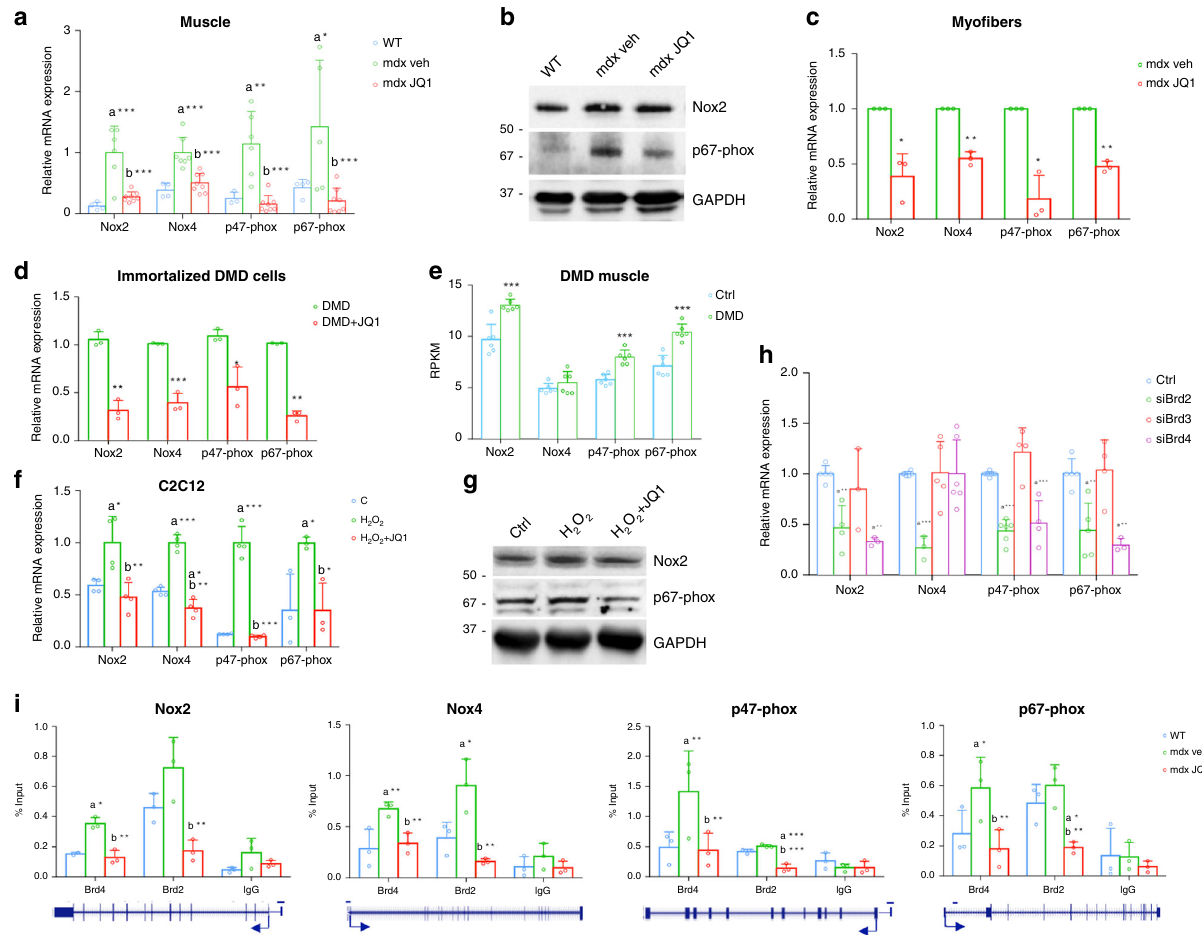
Fig. 5 JQ1 reduces the transcriptional upregulation of NADPH oxidase subunits. a qRT-PCR analysis of Nox2 (WT, n = 4; mdx, n = 6; mdx + JQ1, n = 8), Nox4 (WT, n = 4; mdx, n = 7; mdx + JQ1, n = 8), p47-phox (WT, n = 3; mdx, n = 6; mdx + JQ1, n = 8) and p67-phox (WT, n = 4; mdx, n = 5; mdx + JQ1, n = 8) mRNAs in TAs from control, vehicle-, and JQ1-treated mice. Data are normalized against HPRT and expressed as the mean ± SD. b Representative images of immunoblot analysis for Nox2 and p67-phox in TAs from control, vehicle-, JQ1-treated mice. GAPDH serves as a loading control. WT animals: n = 3 for each experimental group. c qRT-PCR analysis of NADPH oxidase subunit mRNAs in myo fi bers isolated from mdx EDL muscles and treated with 200 nM JQ1 for 16 h. Data are normalized against HPRT and expressed as the mean ± SD, n = 3 animals. d qRT-PCR analysis of NADPH oxidase subunit mRNAs in immortalized DMD myoblast cells treated with 200 nMJQ1 for 24 h. Data are normalized against GAPDH and expressed as the mean ± SD, n = 3 immortalized cell lines. e RPKM expression levels of NADPH subunit transcripts in published RNA-Seq dataset for DMD ( n = 6) and healthy donors ( n = 6). Data are expressed as a mean ± SD. f qRT-PCR analysis of Nox2, Nox4, p47 phox ( n = 4 for each experimental group) and p67-phox ( n = 3 for each experimental group) mRNAs in C2C12 myotubes cells were pretreated with 200 nM JQ1 and then co-treated with 250 μ M H 2 O 2 for 8 h. Data are normalized against GAPDH and expressed as the mean ± SD. g Representative images of immunoblot analysis for Nox2, p67-phox and BRD4 in C2C12 myoblasts treated as in ( e ). GAPDH serves as a loading control. h qRT-PCR analysis of Nox2 (Ctrl, n = 5; siBrd2, n = 4; siBrd3, n = 3; siBrd4, n = 3), Nox4 (Ctrl, n = 5; siBrd2, n = 3; siBrd3, n = 5; siBrd4, n = 5), p47-phox (Ctrl, n = 5; siBrd2, n = 6; siBrd3, n = 4; siBrd4, n = 4) and p67-phox (Ctrl, n = 5; siBrd2, n = 5; siBrd3, n = 4; siBrd4, n = 3) subunit mRNAs in C2C12 cells in which BRD2, BRD3, BRD4 levels were decreased by siRNAs transfection. Data are normalized against GAPDH and expressed as the mean ± SD. i ChIP assay with BRD2 and BRD4 antibodies in control, vehicle- and JQ1-treated muscles showing recruitment at regulatory regions of Nox2, Nox4, p47-phox and p67-phox genes. Data represent mean ± SD, n = 3 animals A schematic representation below the diagrams shows the region ampli fi ed in ChIP. In all panels, statistical signi fi cance was determined by using one-way ANOVA followed by Tukey ’ s post hoc test. a indicates statistical signi fi cance compared to the group presented in the fi rst column; b indicates statistical signi fi cance compared to the group presented in the second column. * P < 0.05; ** P < 0.01; *** P <